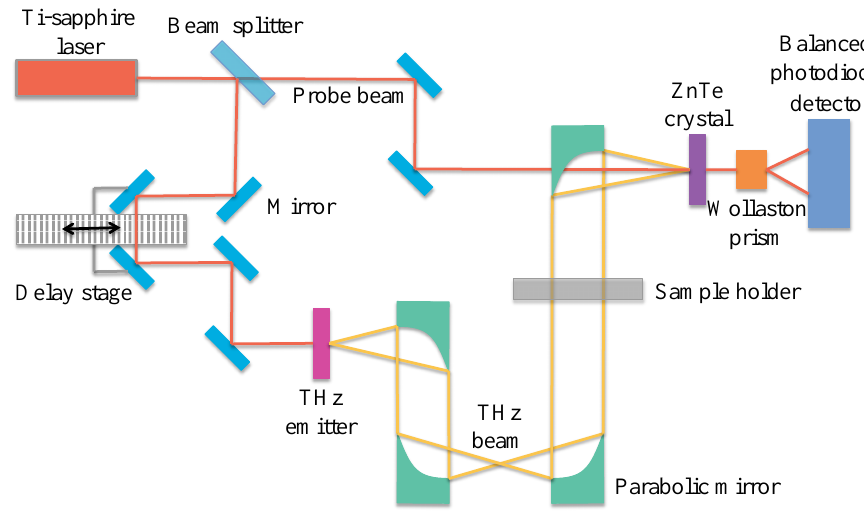
Figure 8. Schematic of a time-domain spectroscopy THz measurement system as used in [10] for LC characterization. By comparing the measurement results of an empty and a LC-filled sample holder, the dielectric properties of LC can be determined.